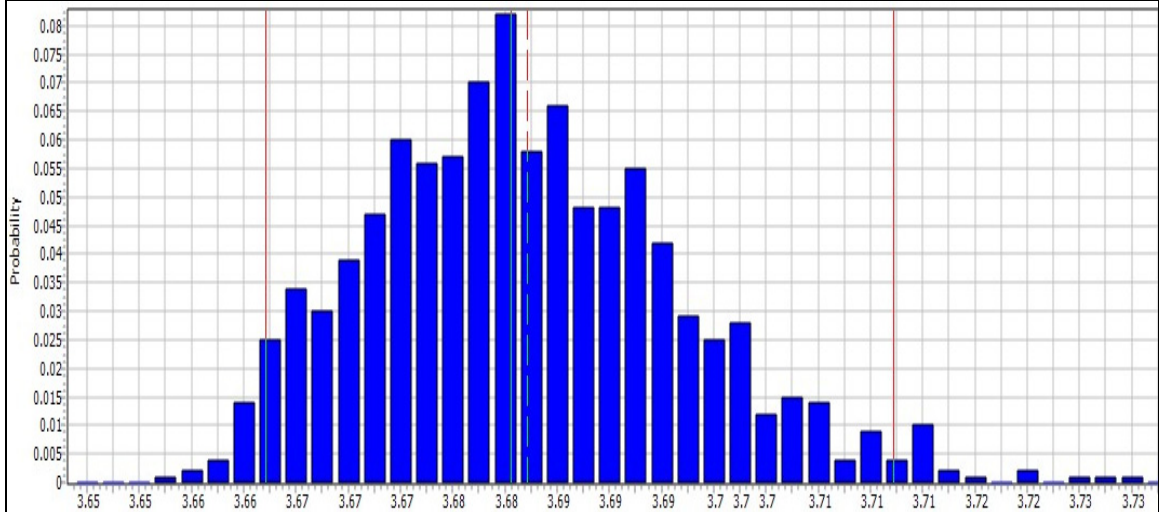
Figure 5. The uncertainty analysis of 1 m 3 of drinking water from the operational phase in the SWRO plant.